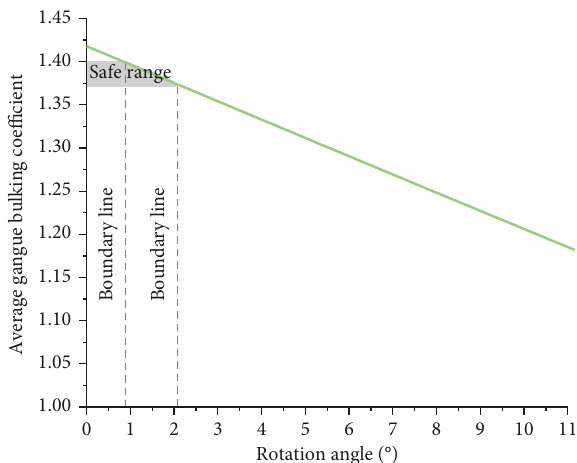
Figure 8: Relationship between the average gangue bulking co- efficient and the rotation